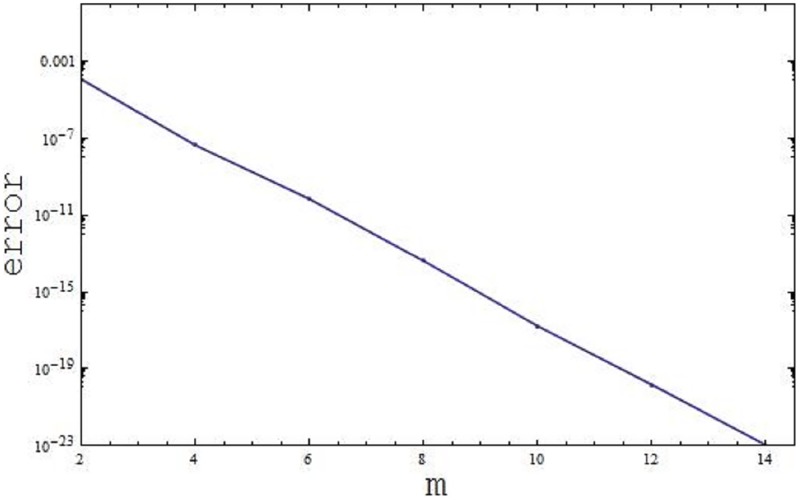
Display the error decay for the 10th order approximation.